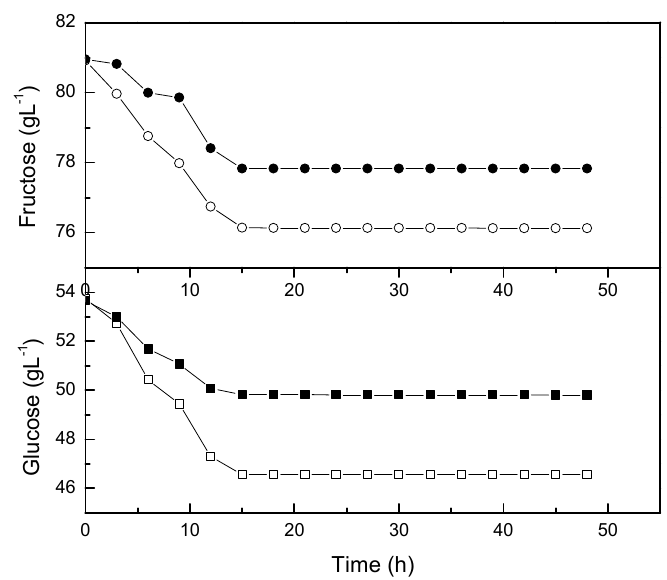
Figure 6. Consumption by L. casei in shake flasks. The open symbol is growth kinetic at 0 rpm and the closed symbol is growth kinetic at 50 rpm.